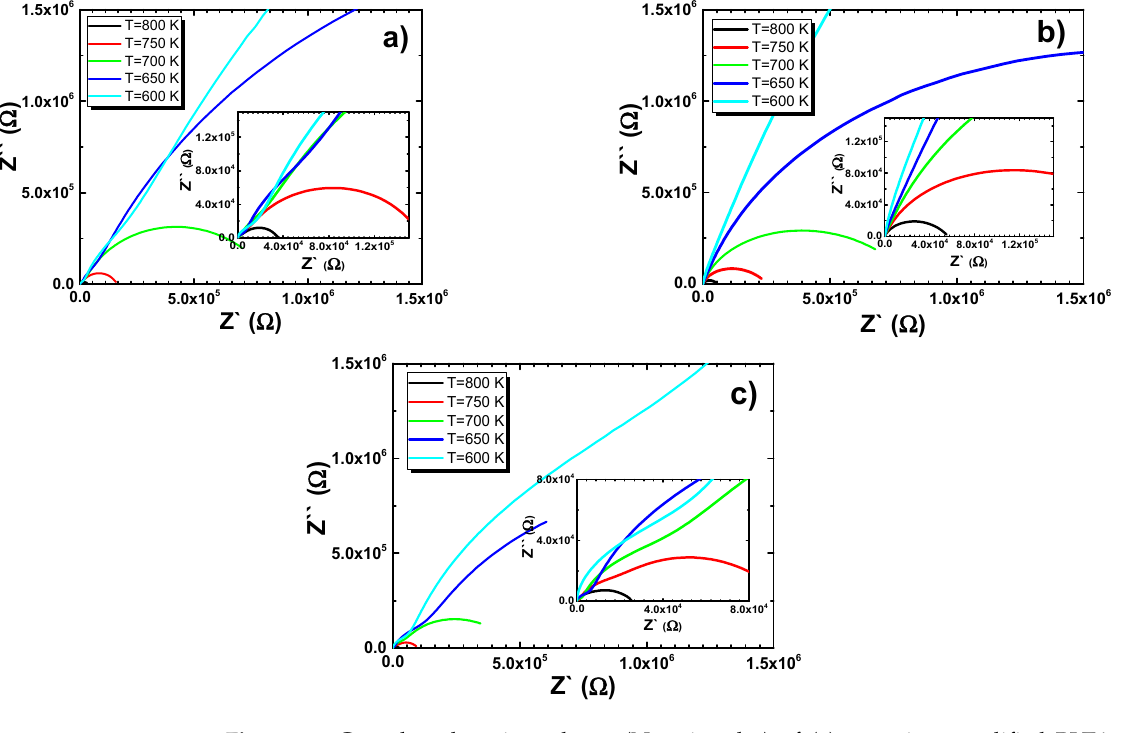
Figure 9. Complex-plane impedance (Nyquist plot) of ( a ) europium-modified BLT4 ceramics, ( b ) hafnium-modified BLT4 ceramics, and ( c ) simultaneously hafnium- and europium-modified BLT4 ceramics.